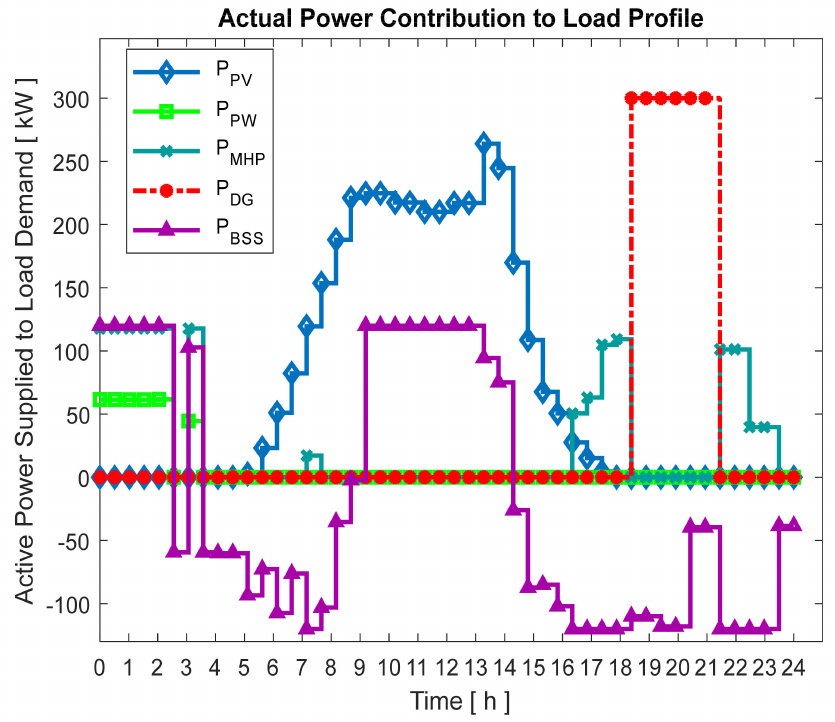
Figure 14. Actual energy contribution to load demand profile by individual power sources.